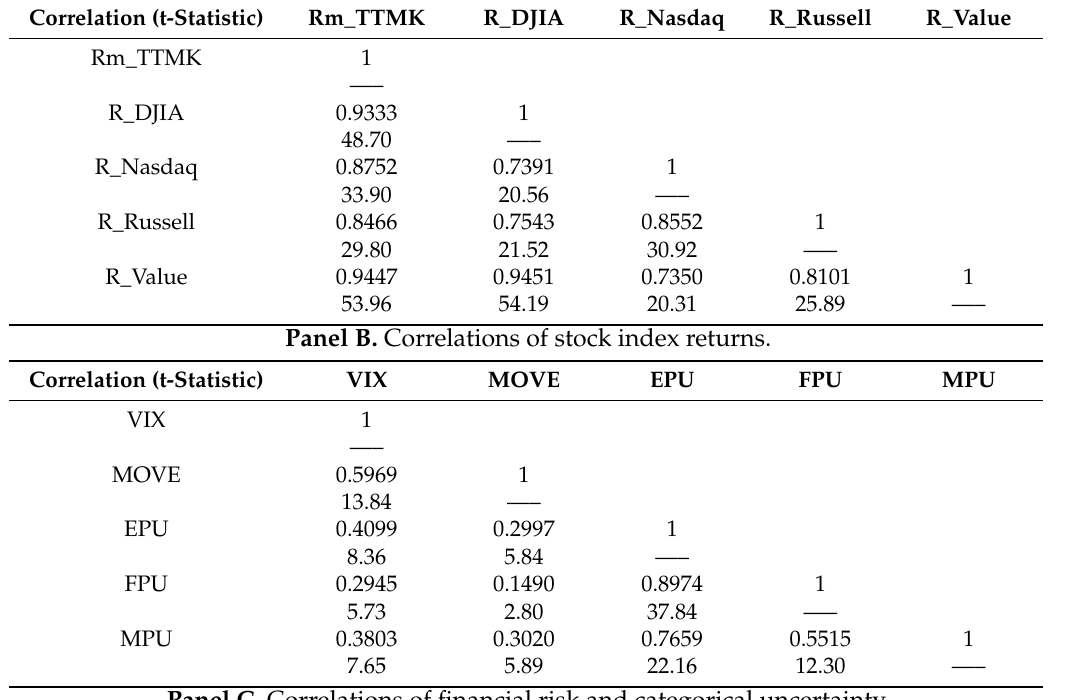
Panel C. Correlations of financial risk and categorical uncertainty.